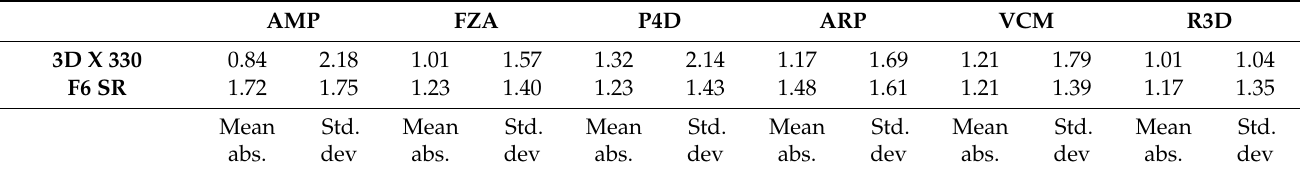
Table 15. Hausdorff distances between the 3D scanning and photogrammetric models from dataset 4 (distances in mm). 3D X 330 0.84 2.18 1.01